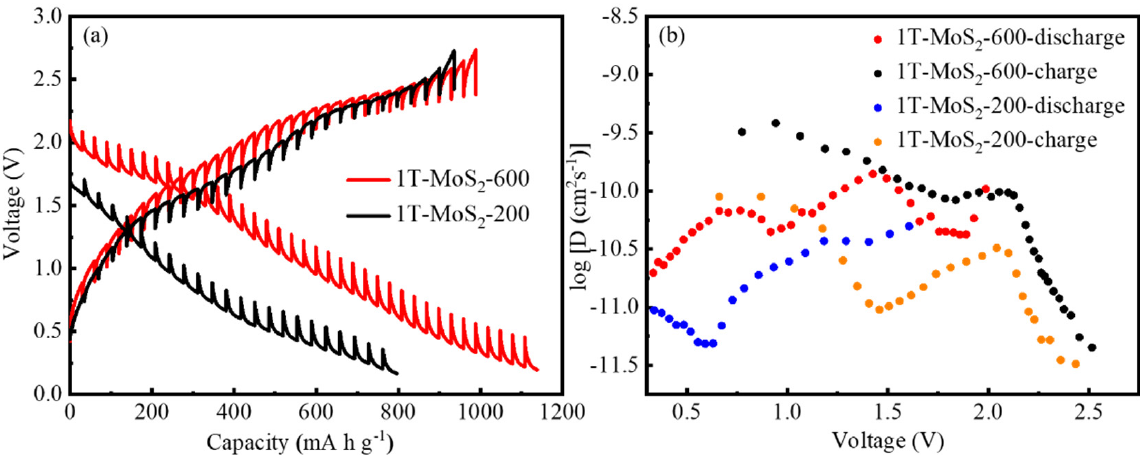
Figure 9. ( a ) The discharge–charge GITT plots at 0.1 C, and ( b ) lithium − ion diffusion coefficient of 1T − MoS 2 − 600 and 1T − MoS 2 − 200 at the discharge and charge processes,